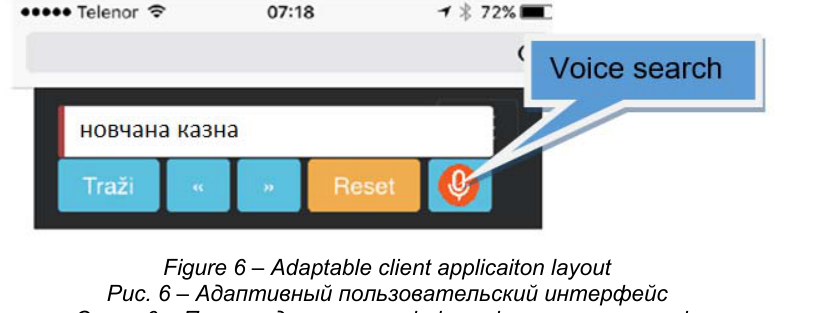
Figure 6 – Adaptable client applicaiton